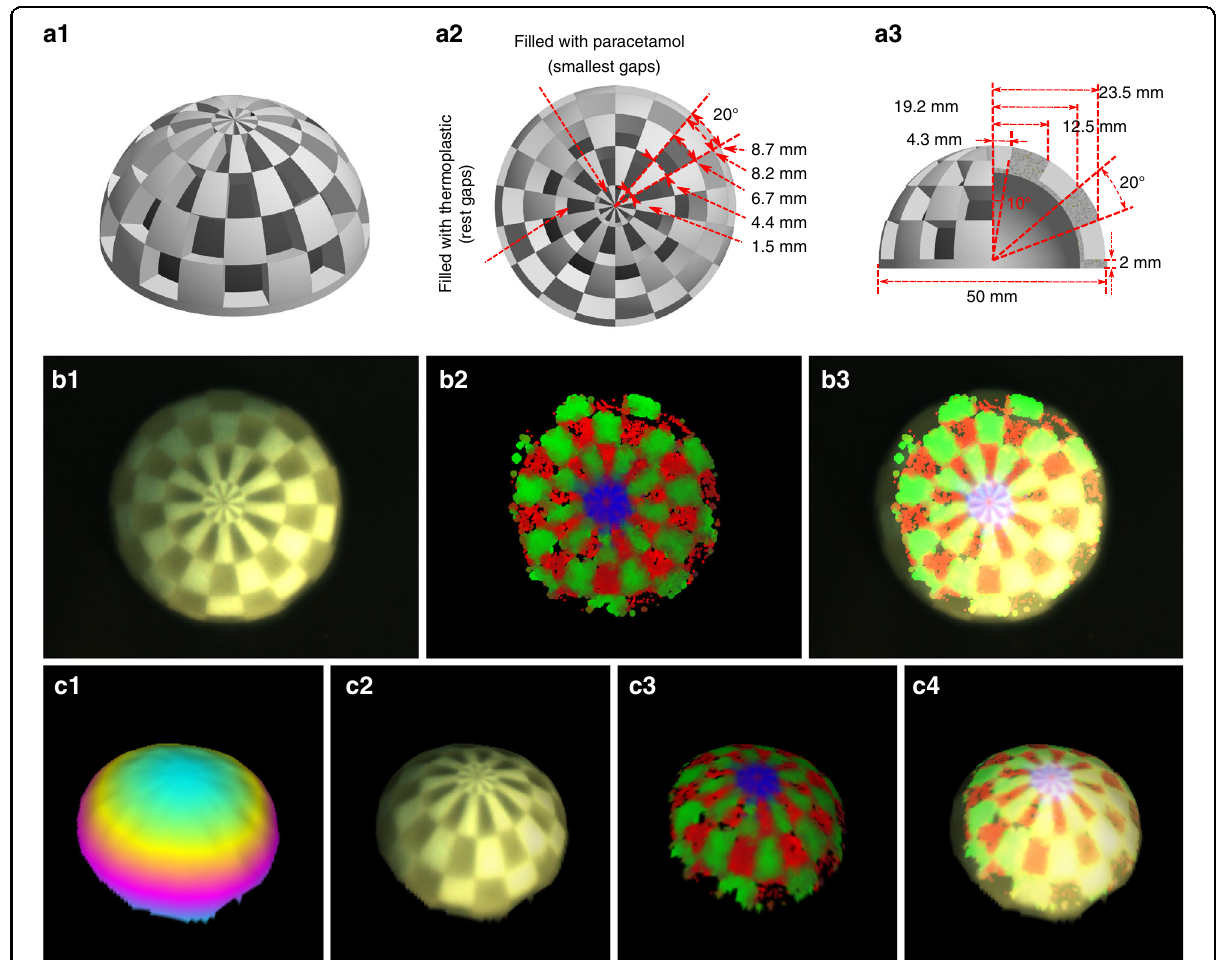
Fig. 4 Combination with the photometric stereo. a 1 Diagram of the PMMA hemisphere phantom with 20°-slices from the center on the horizontal plane and vertical plane. The spaced area on the top surface is hollowed and the small gaps re fi lled with paracetamol, while the remaining gaps are fi lled with moldable thermoplastic (polycaprolactone). a 2 Top-view of the phantom, which shows the arc lengths of a 20° slice on each horizontal level. a 3 Three-quarter side-view of the phantom, which shows the radiuses of each horizontal level. The diameter of the hemisphere is 50 mm and the thickness of the basement is 2 mm. b 1 – 3 Top-view on the sample. b 1 Bright fi eld image of the hemisphere phantom, where no molecular boundaries can be discerned. b 2 Reconstructed Raman image by the developed imaging approach with the handheld operation with clear molecular boundaries, and b 3 overlayed with the bright fi eld image as augmented molecular information. c 1 A representative image of the height map of the phantom through photometric stereo. c 2 The bright fi eld image textured height map, viewed from the same angle, and c 3 , with relevant molecular-textured 3D image. c 4 The three modes combined and represented as 3D augmented molecular image. The color information represents the different chemical components, i.e., red for PMMA, green for thermoplastic (polycaprolactone), and blue for